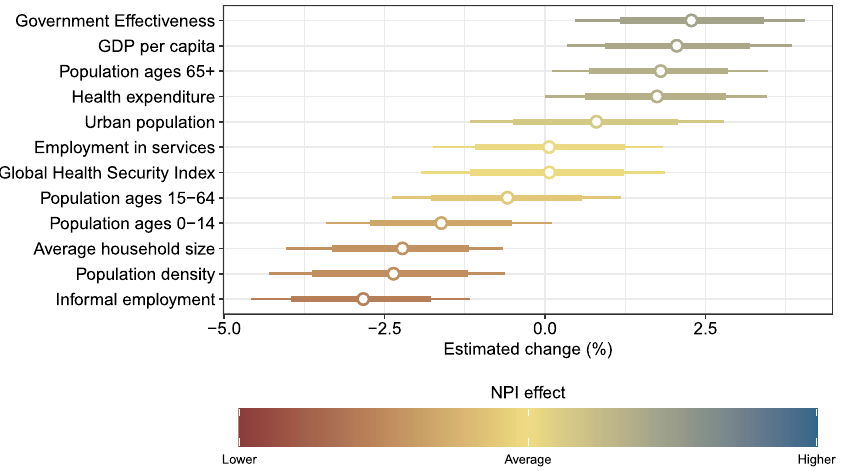
Figure 4. Estimated relative change (in %) in avoided new infections compared to the cross-country average effect of the single NPIs (posterior distribution with mean as dots and with 80% and 95% credible interval as thick and thin lines, respectively) for a + 1 standard deviation (SD) increase in the variable with the country characteristic.